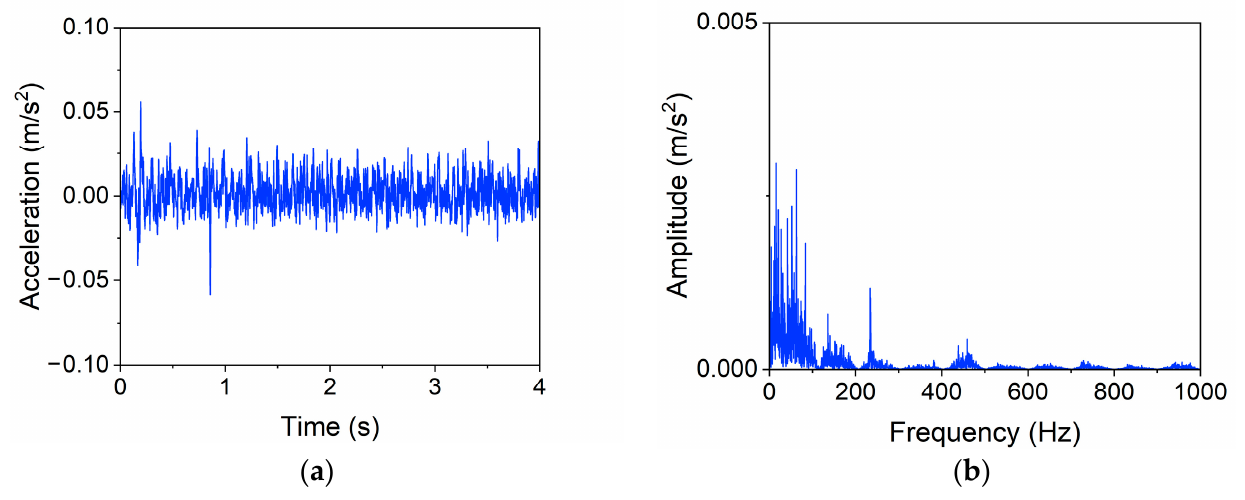
Figure 14. Representative signal after fi ltering. ( a ) Time domain, ( b ) Frequency domain.